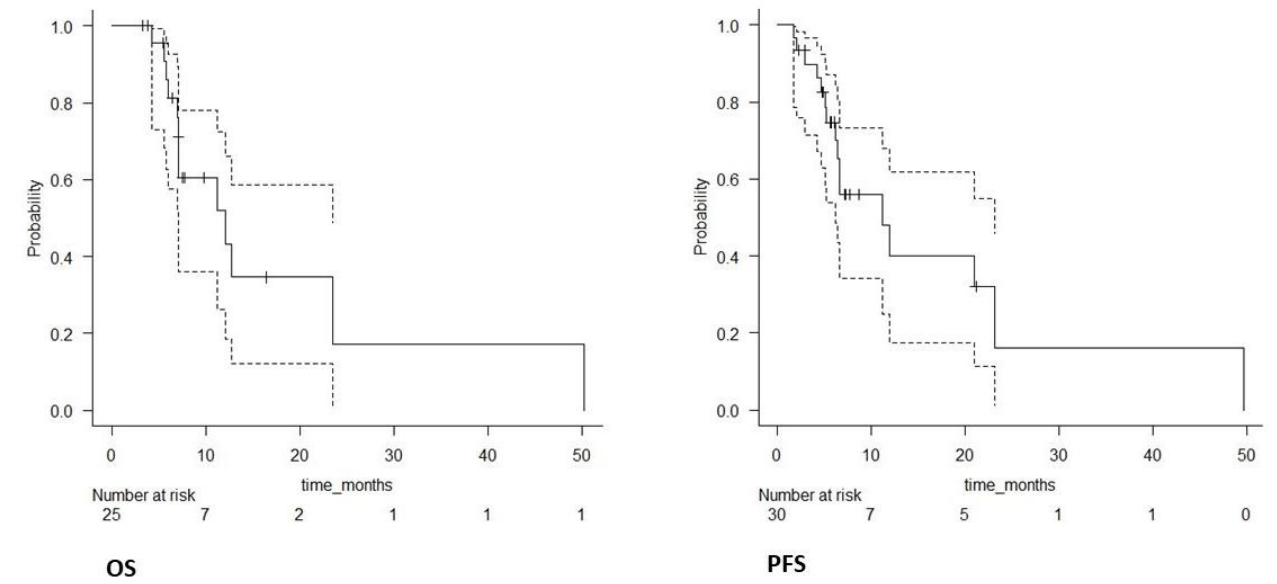
Figure 2. OS and PFS Kaplan–Meier survival curves of the entire population (solid lines); confidence intervals (dotted lines).